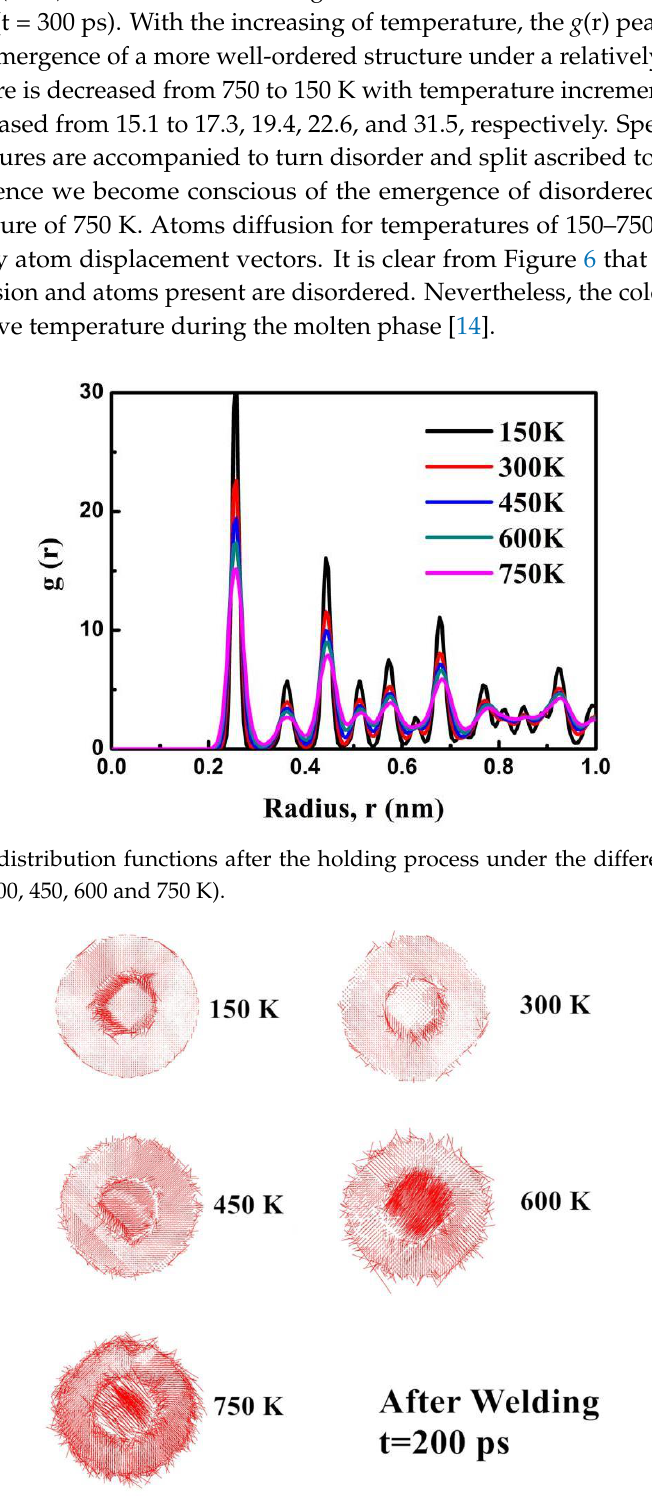
Figure 6. Atoms diffusion for temperatures of 150–750 K after holding (t = 300 ps) are shown by atom displacement vectors.